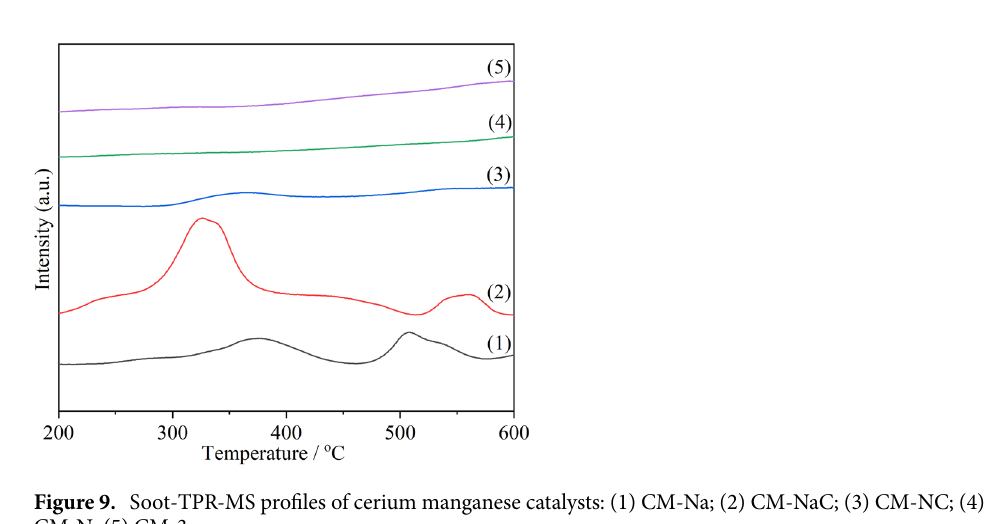
Figure 8. O 2 -TPD profiles of cerium manganese catalysts: (1) CM-Na; (2) CM-NaC; (3) CM-NC; (4) CM-N; (5) CM-3.